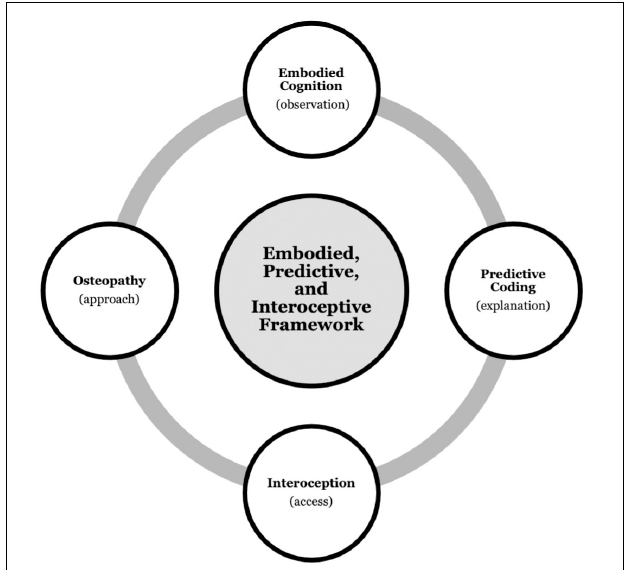
FIGURE 1 | Background synthesis. Integrating the research fields of embodied cognition, predictive coding, interoception, and osteopathy to propose an embodied, predictive, and interoceptive framework to osteopathy and mental